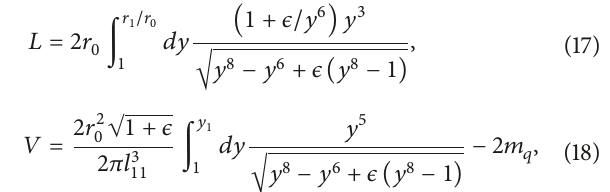
where 𝑅 2 is a constant defined by 𝑅 2 = (32𝜋𝑁𝑙 6 11 ) number of coincident branes, 𝑙 11 is Plank’s length in eleven dimensions, and 𝑑Ω 7 is the differential solid angle for seven-